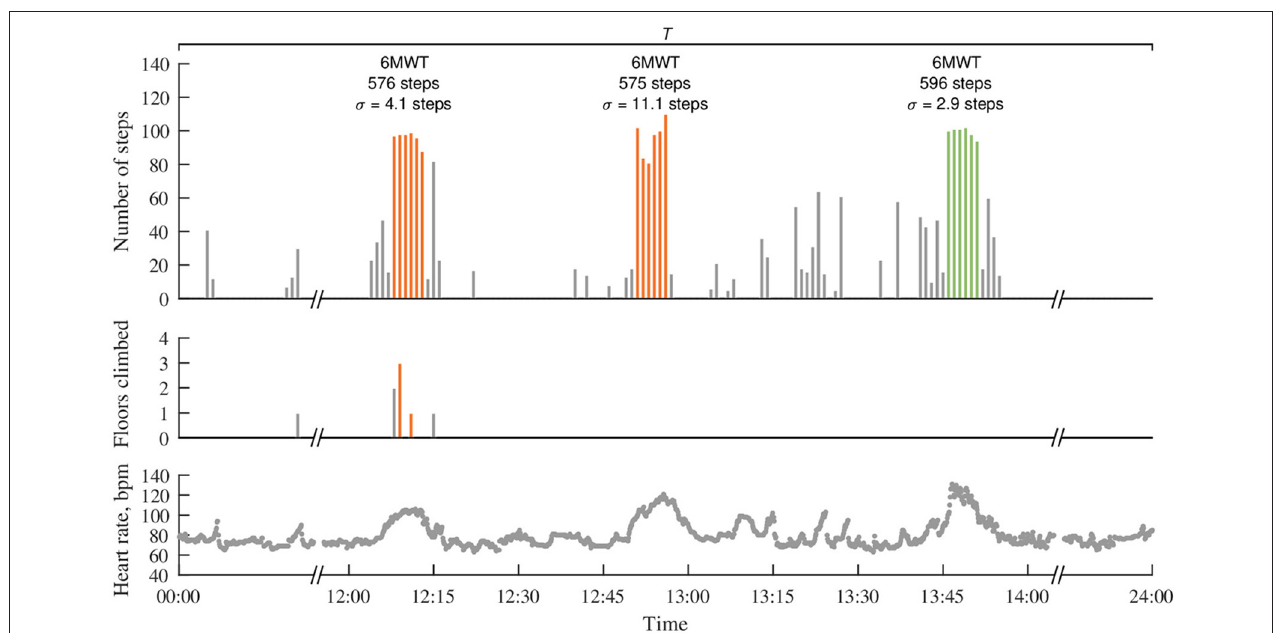
FIGURE 1 | Detection of an unintentional 6MWT in minute-to-minute step data acquired in free-living activities using a wrist-worn device. The most representative 6MWT with the largest number of steps is depicted in green, whereas 6MWTs of other candidate, which either have a smaller number of steps or do not satisfy the determined criteria (e.g., contain stair climbing or cadence variation σ > 5 steps), are depicted in orange. Note that heart rate is not used for the detection of candidate walk tests but only serves for determining the subject-specific reference walking distance, to which the estimated distance is judged, refer to the Equation in (2).